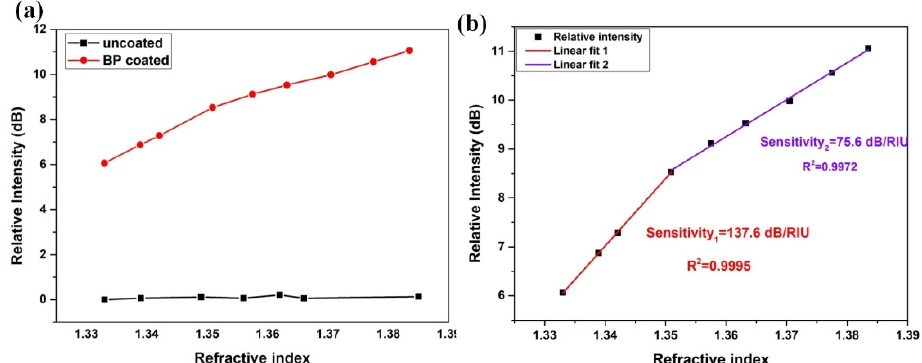
Figure 8. ( a ) The relative intensity for the minima of deepest cladding mode around 1552 nm of bare or black phosphorus integrated with weakly tilted fiber Bragg grating (BP-WTFBG) in the 1.33–1.38 RI region. ( b ) The linear fit for the relative intensity of BP-WTFBG against di ff erent